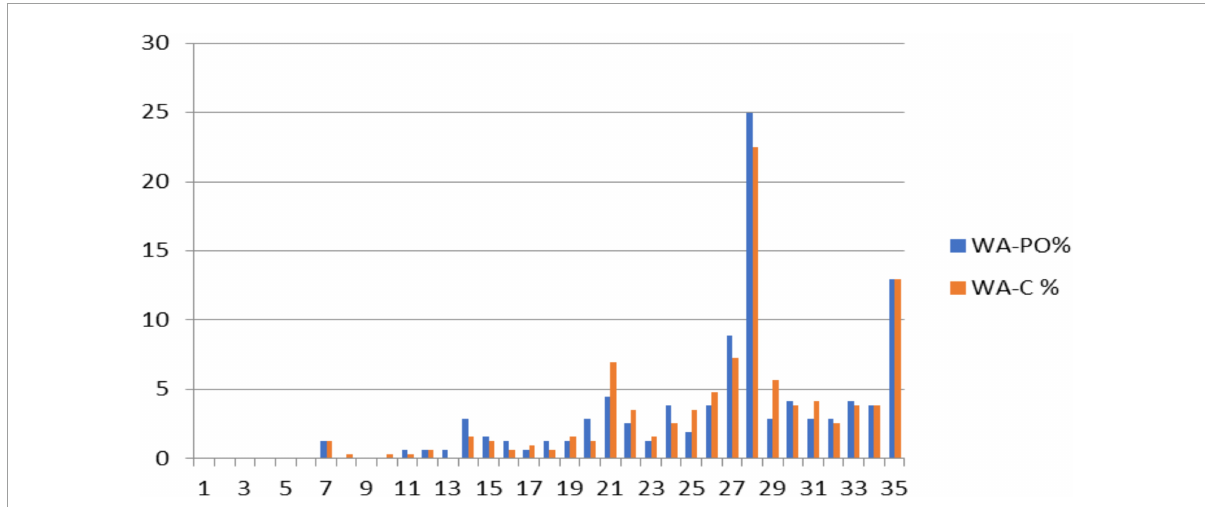
FIGURE1 Percentage of endorsement for total scores for WA-CO and WA-PO. Nodes at 28 and 35 for total scores indicate a high proportion of respondents chose response options “4” or “5” for WA-CO and WA-PO. WA-PO refers to the parole officer version of the WAI, while WA-C refers to the counselor